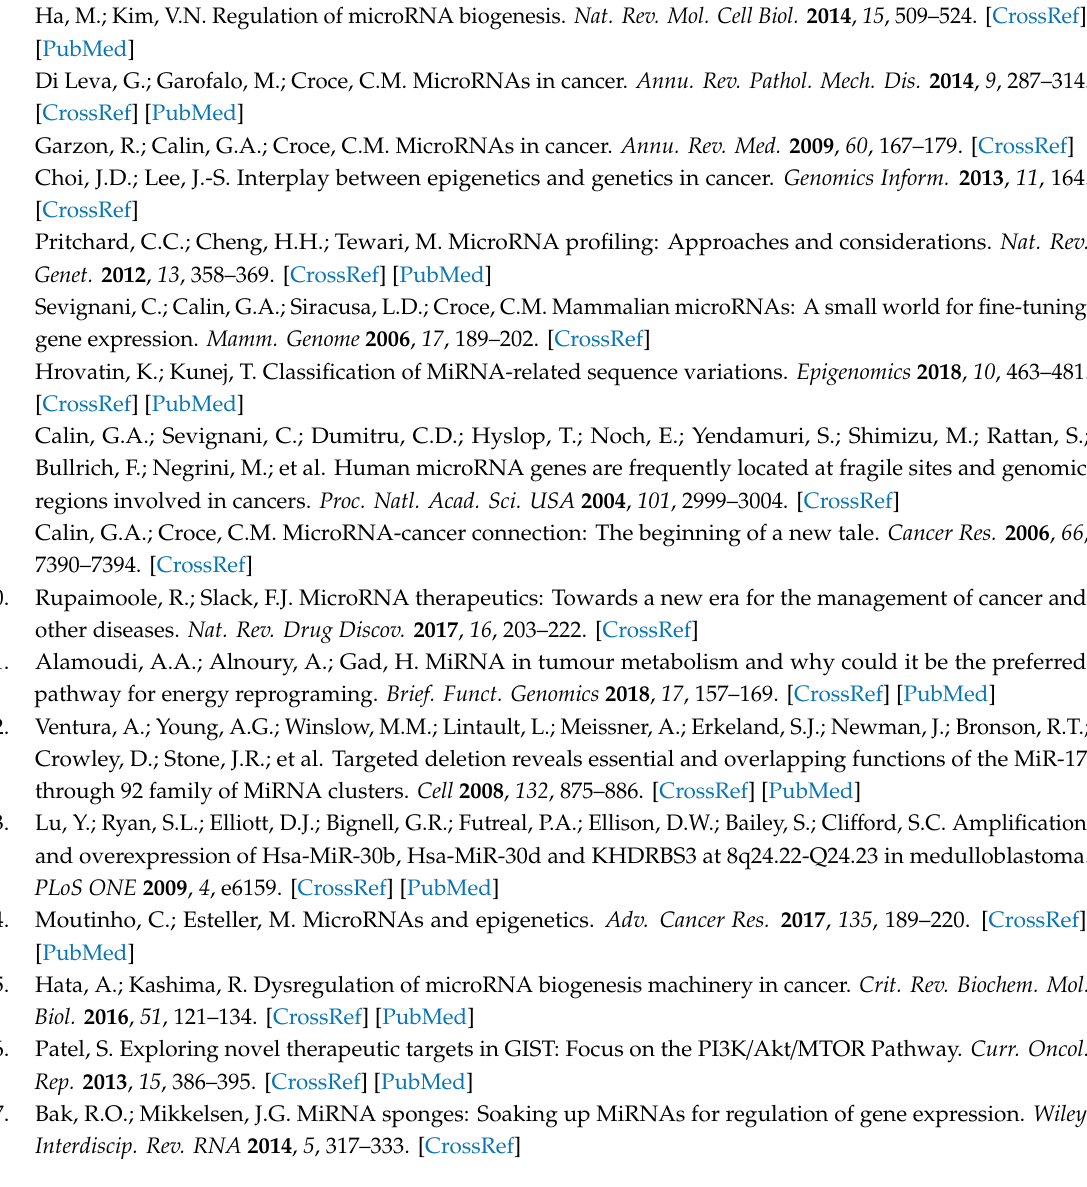
Figure S1: Forest plots for the e ff ect of miR-221 overexpression and CSS and DSS, Figure S2: Forest plots for the e ff ect of miR-221 overexpression and OS / CSS / DSS, Figure S3: Forest (A) and Funnel (B) plots for the e ff ect of miR-221 overexpression on DFS / RFS. (B), Figure S4: Forest plots for the e ff ect of miR-222 overexpression and OS / DSS, Figure S5: Forest (A) and Funnel (B) plots for the e ff ect of miR-222 overexpression on PFS, Figure S6: Forest plots for the e ff ect of miR-222 overexpression and RFS / DFS, Figure S7: Sensitivity analysis of the meta-analysis for miR-221 (A) and miR-222